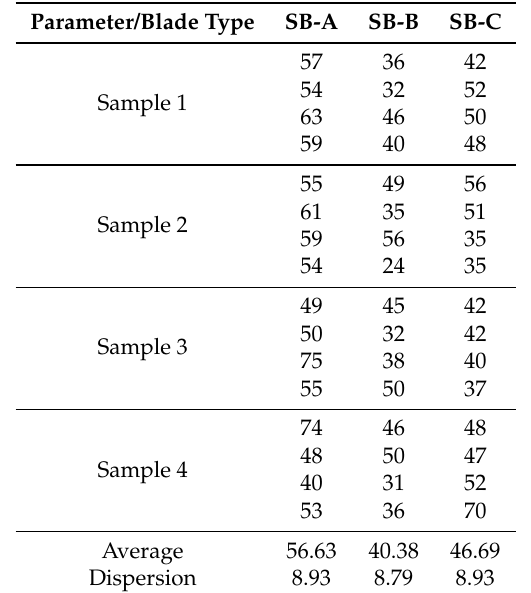
Table 1. Quantity of diamonds per segment of each type of blade.